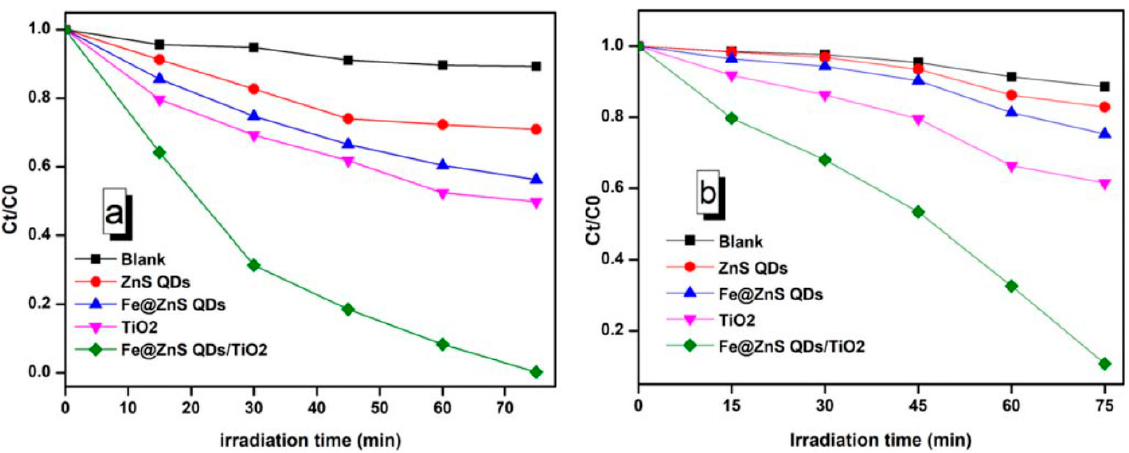
Figure 4. Change in concentration of Rhodamine B (RhB) ( a ) and paracetamol ( b ) as a function of time in the presence of different catalysts under visible light illumination. Reproduced with permission [59].